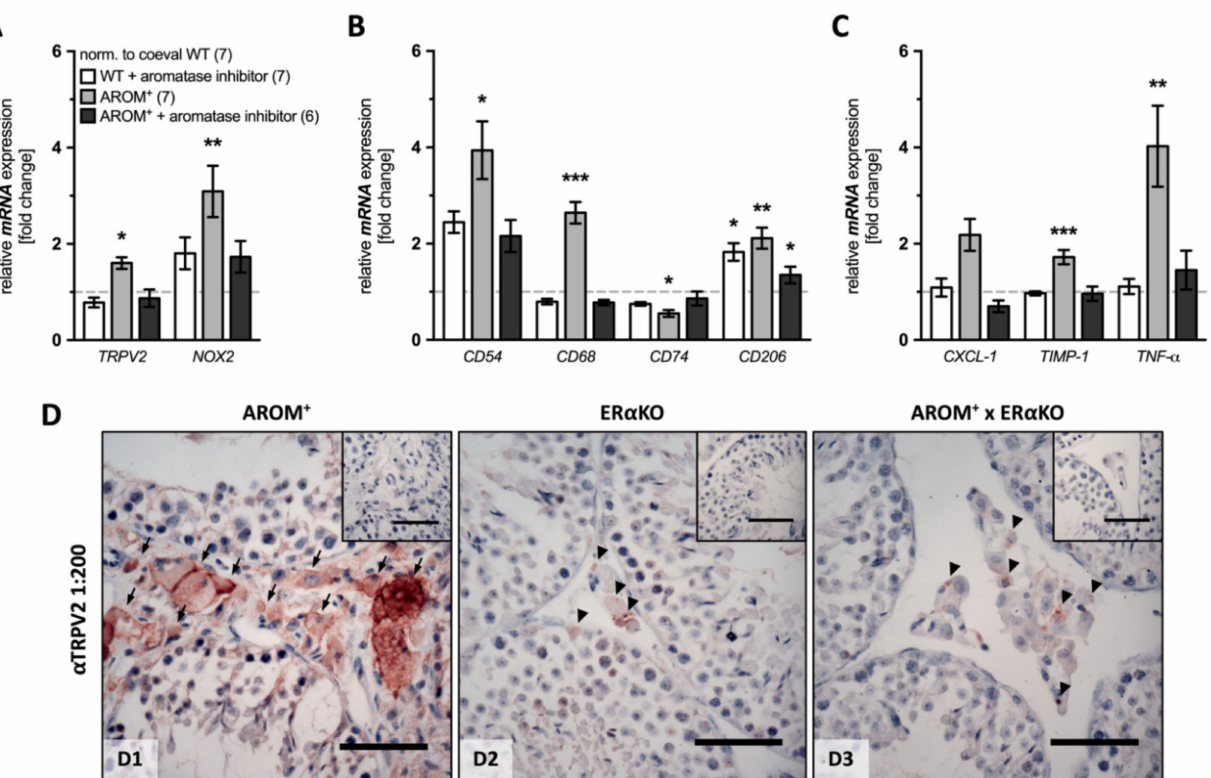
Figure 5. Rescue experiments of AROM + mice prevent TRPV2 increases. ( A – C ) One month-old WT and AROM + mice were treated with an aromatase inhibitor or with corresponding placebo for 6 weeks and whole testes were analyzed for their mRNA expression profile of ( A ) TRPV2 and NOX2 , ( B ) macrophage and ( C ) inflammation markers. The graphs represent mean ± SEM of inhibitor-treated WT ( n = 7, white bars) and AROM + mice treated with either placebo ( n = 7, light grey bars) or aromatase inhibitor ( n = 6, dark grey bars) compared to coeval placebo-treated WT animals ( n = 7); unpaired two-tailed t -test, α = 0.05; * p ≤ 0.05, ** p ≤ 0.01, *** p ≤ 0.001. ( D ) Immunohistochemistry for TRPV2 performed on testicular sections from 9 month-old AROM + ( D1 ), ER α KO ( D2 ) and AROM + mice crossbred with ER α KO mice ( D3 ) revealed strong positive signals in the interstitial space of AROM + mice mainly membranous in normal-sized and hyperplastic cells (arrows), but only very weak and faint staining within the interstitial space of ER α KO and in AROM + mice crossbred with ER α KO animals, with a rather punctuated pattern (arrow heads). The inserts depict corresponding controls with the omitted 1 st antibody. Scale bar is 50 µ